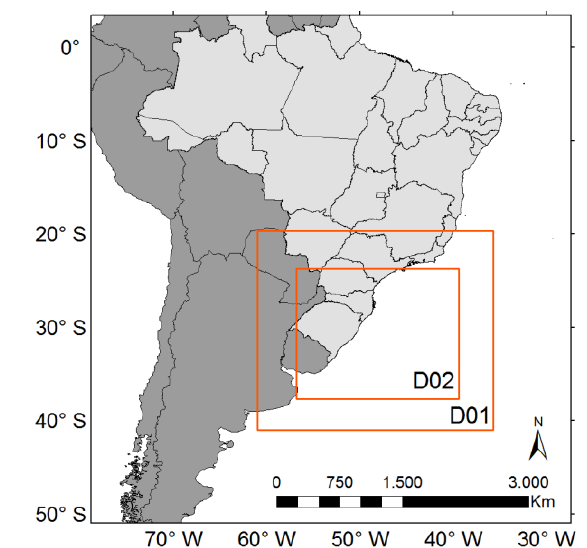
Figure 1. Model domains utilized in the WRF simulations.